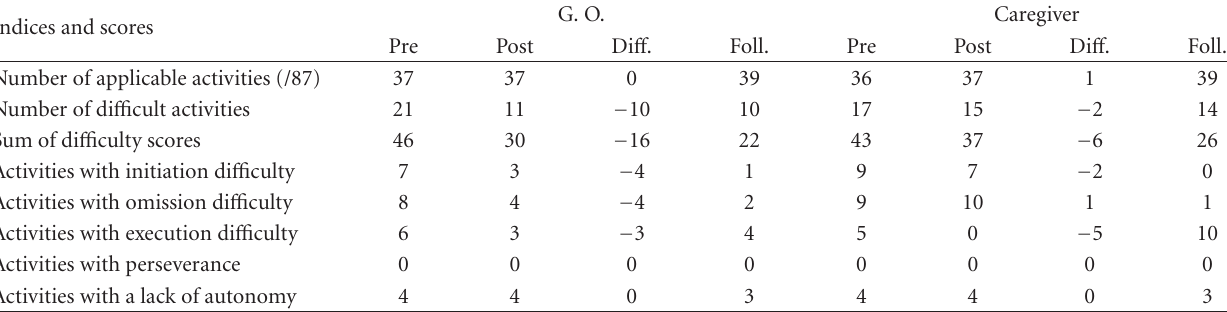
Table 1: Indices and scores for the PROFINTEG general